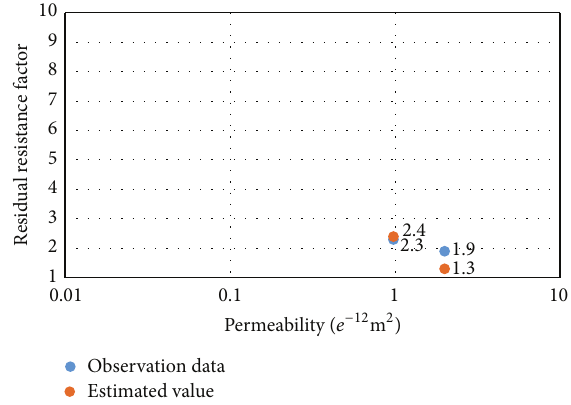
Figure 3: Matching results between observation and estimation using theoretical correlation function of RRF = 𝑎/𝑘 2 + 𝐶 M . Trap + 1.